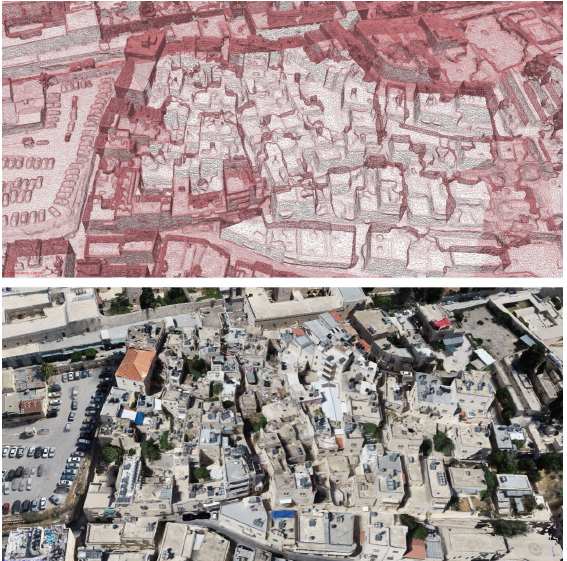
Figure 8: The Agisoft Photoscan visualization of Al- Anatreh 3D model in wireframe and texture mode obtained by DJI Phantom 4 Pro flight plan.